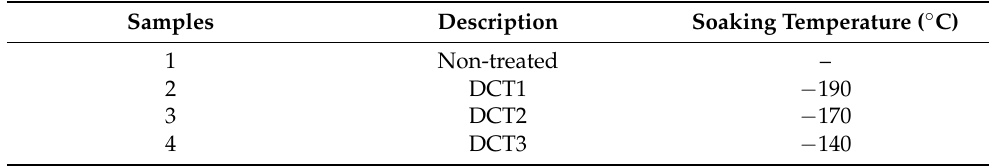
Table 2. Process parameters used in